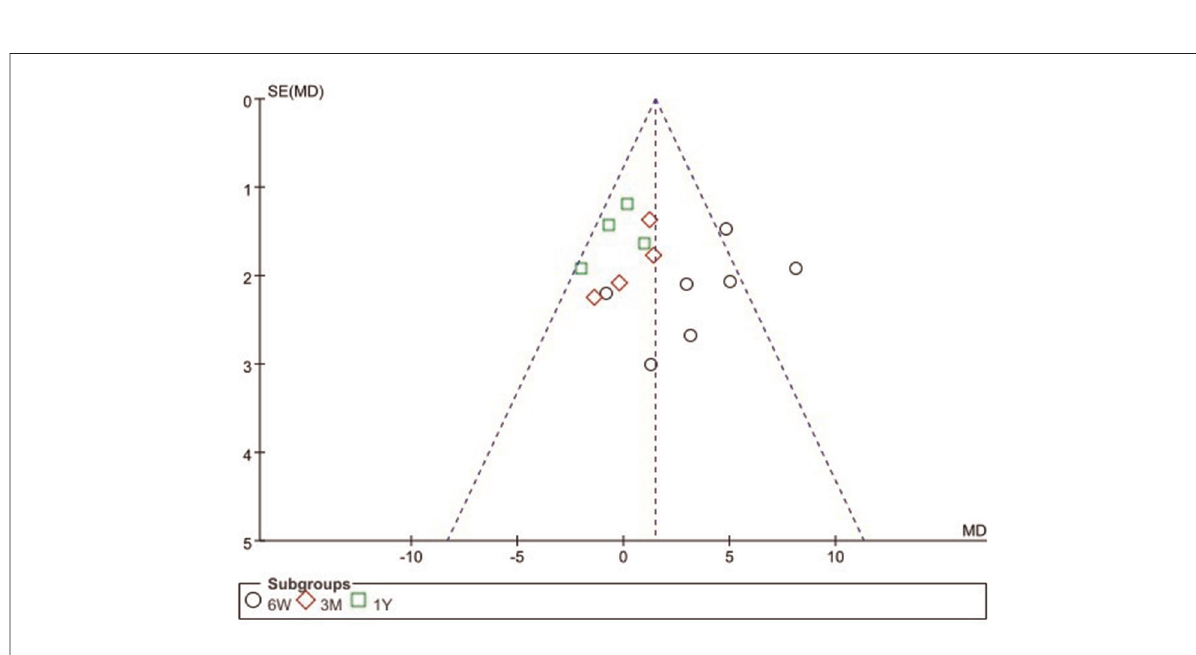
FIGURE 4 Direct anterior approach vs. other approaches: funnel plot of